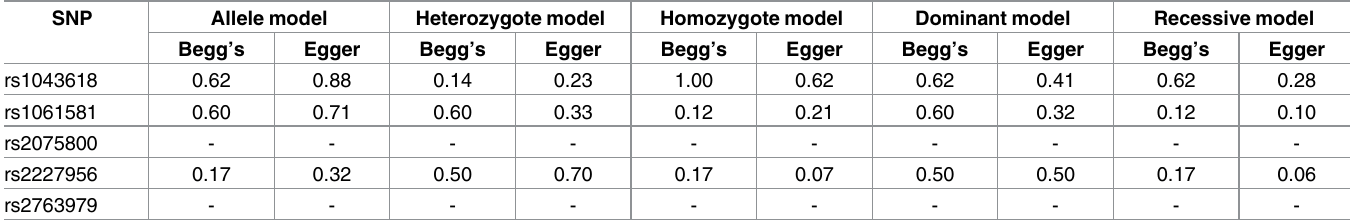
Table 3. Begg’s funnel plot and Egger’s test of the